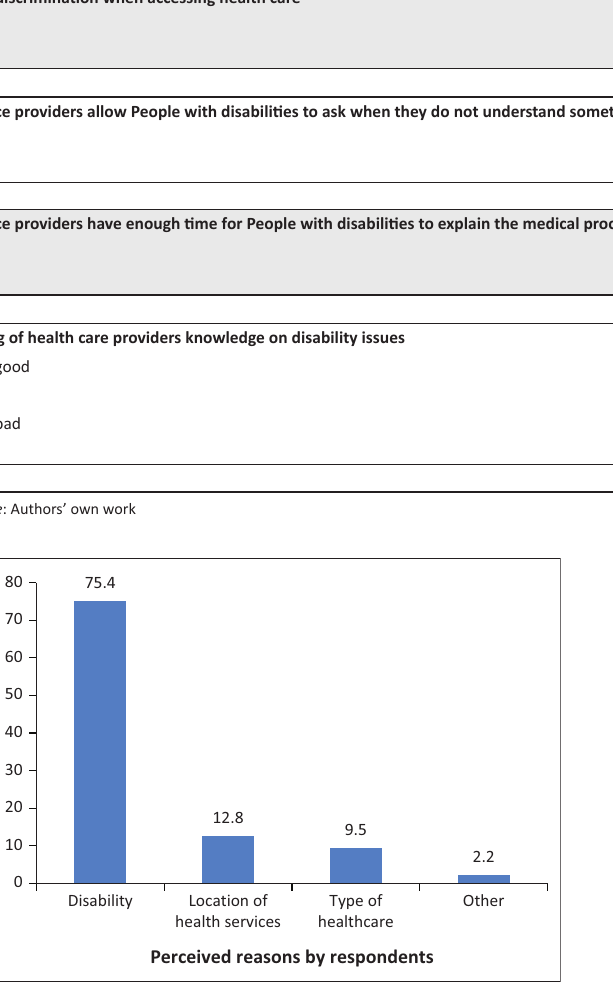
TABLE 2: Percentage distribution of perceived attitudes of health care providers towards People with disabilities. Variables